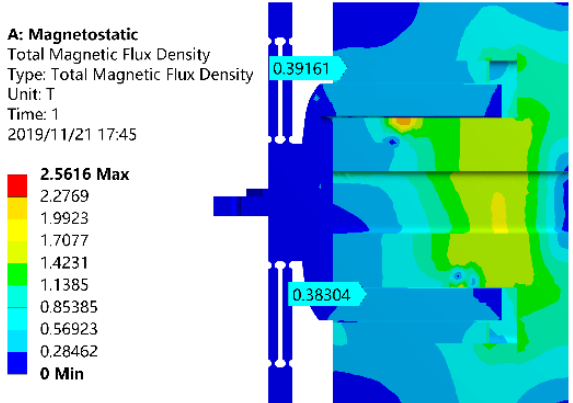
Figure 4. Distribution of the magnetic flux density obtained by finite element analysis (FEA). Table 4. The analytical and FEA results of the FTS.